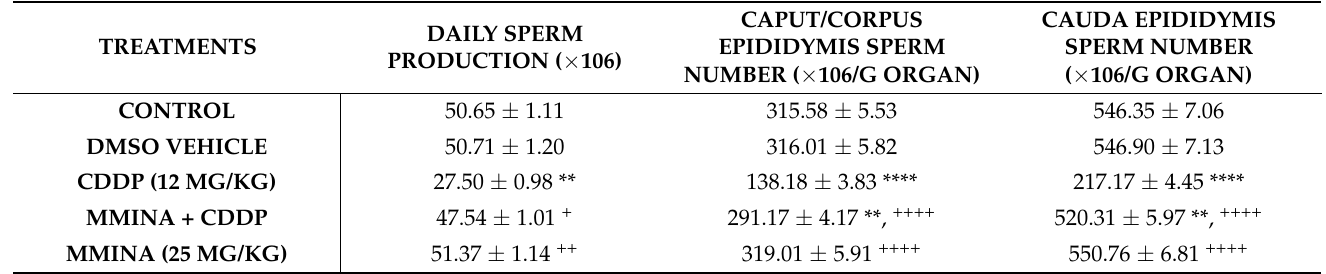
Table 1. Effect of MMINA treatment on daily sperm production (DSP) and sperm number in the